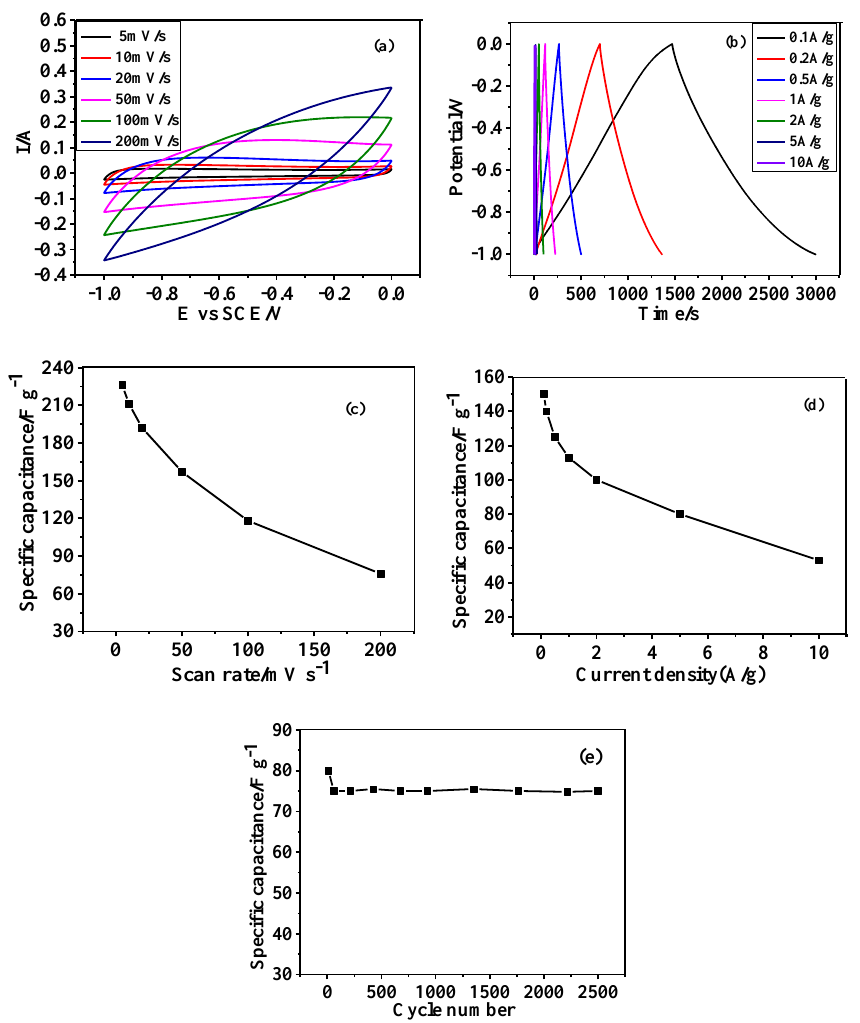
Figure 11. CV curves ( a ), galvanostatic charge/discharge curves ( b ), specific capacitance versus scan rate ( c ), specific capacitance versus current density ( d ), and cycling performance at current density of 5 A/g of as-prepared HGCS ( e ).